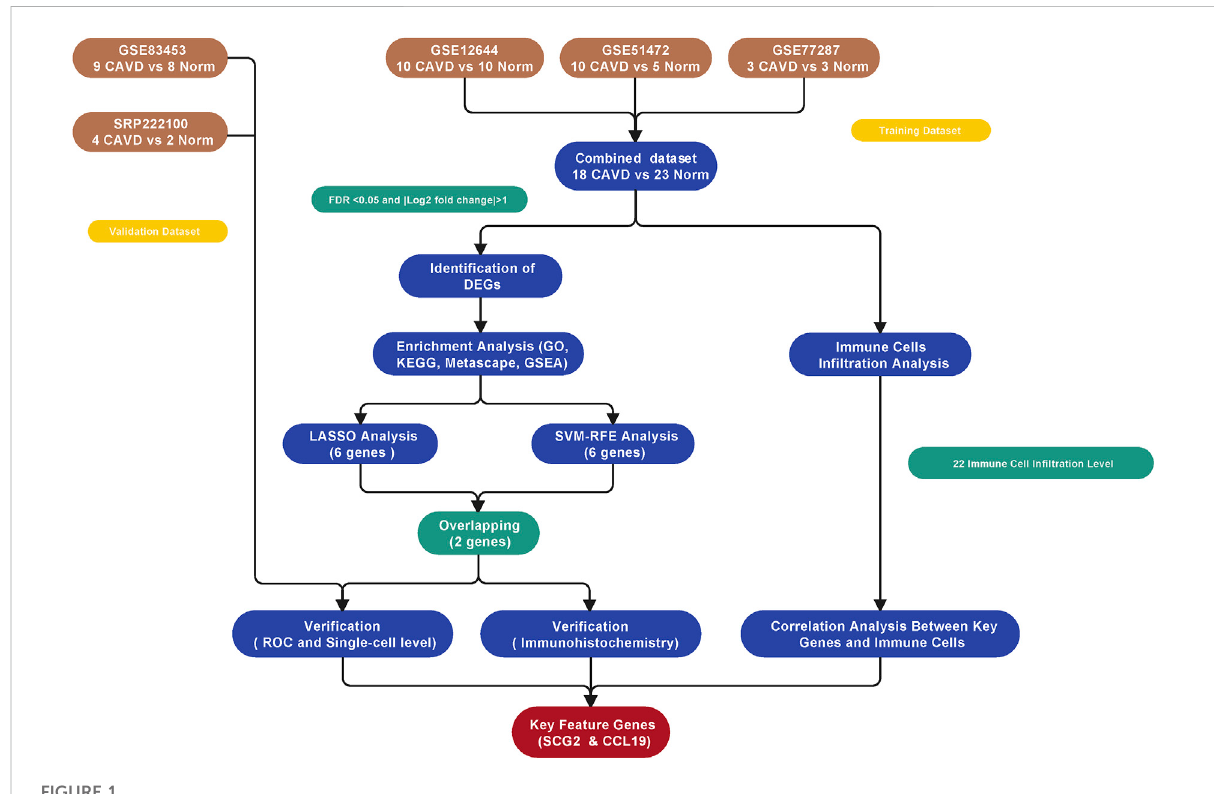
FIGURE 1 Flowchart for analysis in this study.